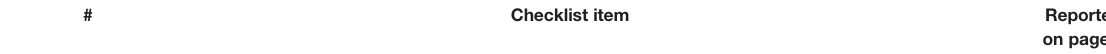
TABLE 1 | The preferred reporting of systematic reviews and meta-analyses (PRISMA)